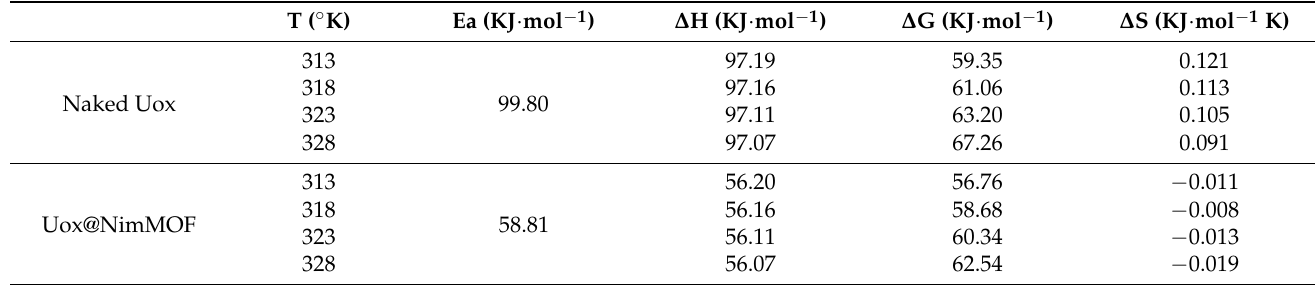
Table 3. Thermodynamic parameters of Uox and